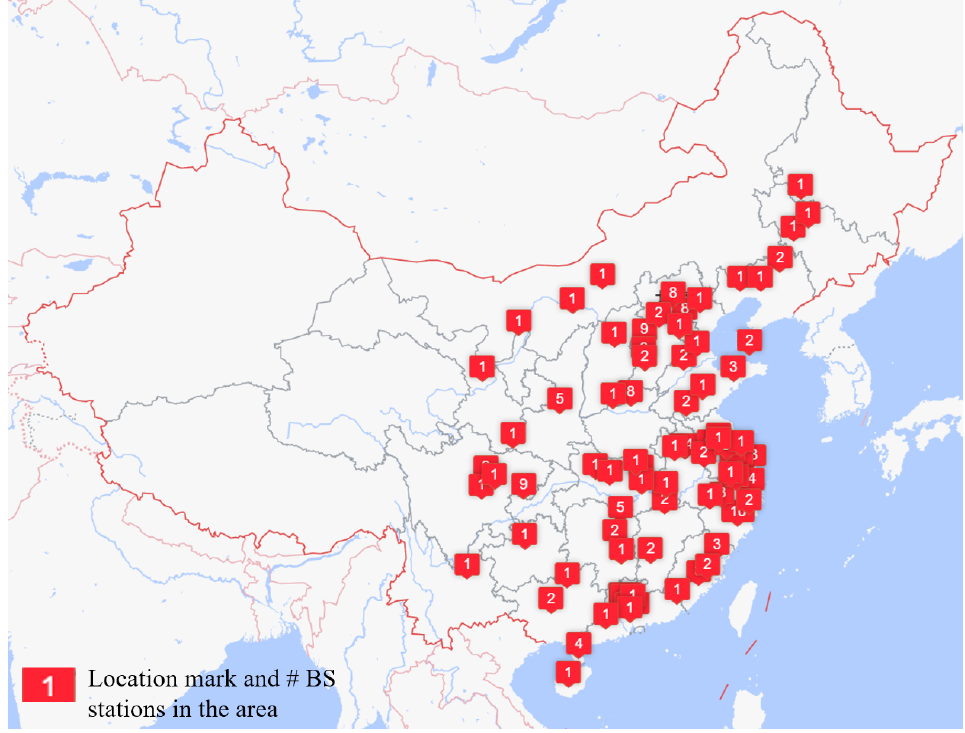
Figure 1. NIO battery swapping